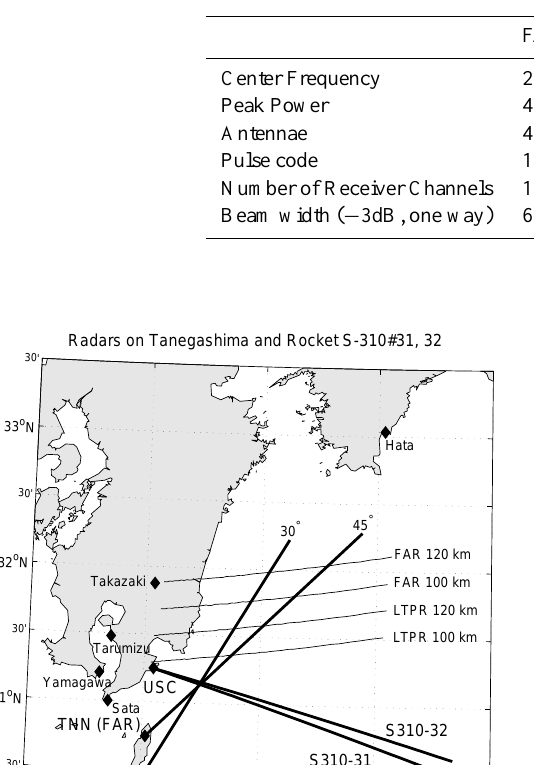
Table 1. Specifications for the FAR and the LTPR